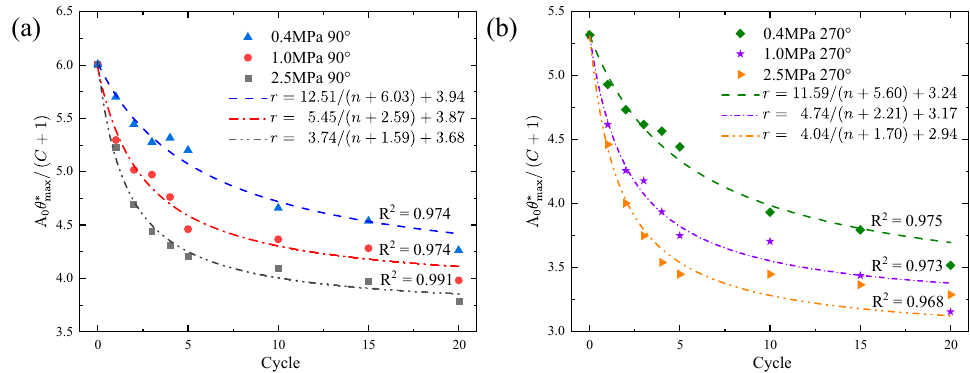
Figure 13. Roughness parameter change process along the cyclic shear directions under different normal stresses: ( a ) 90° and ( b ) 270° analyzed directions.